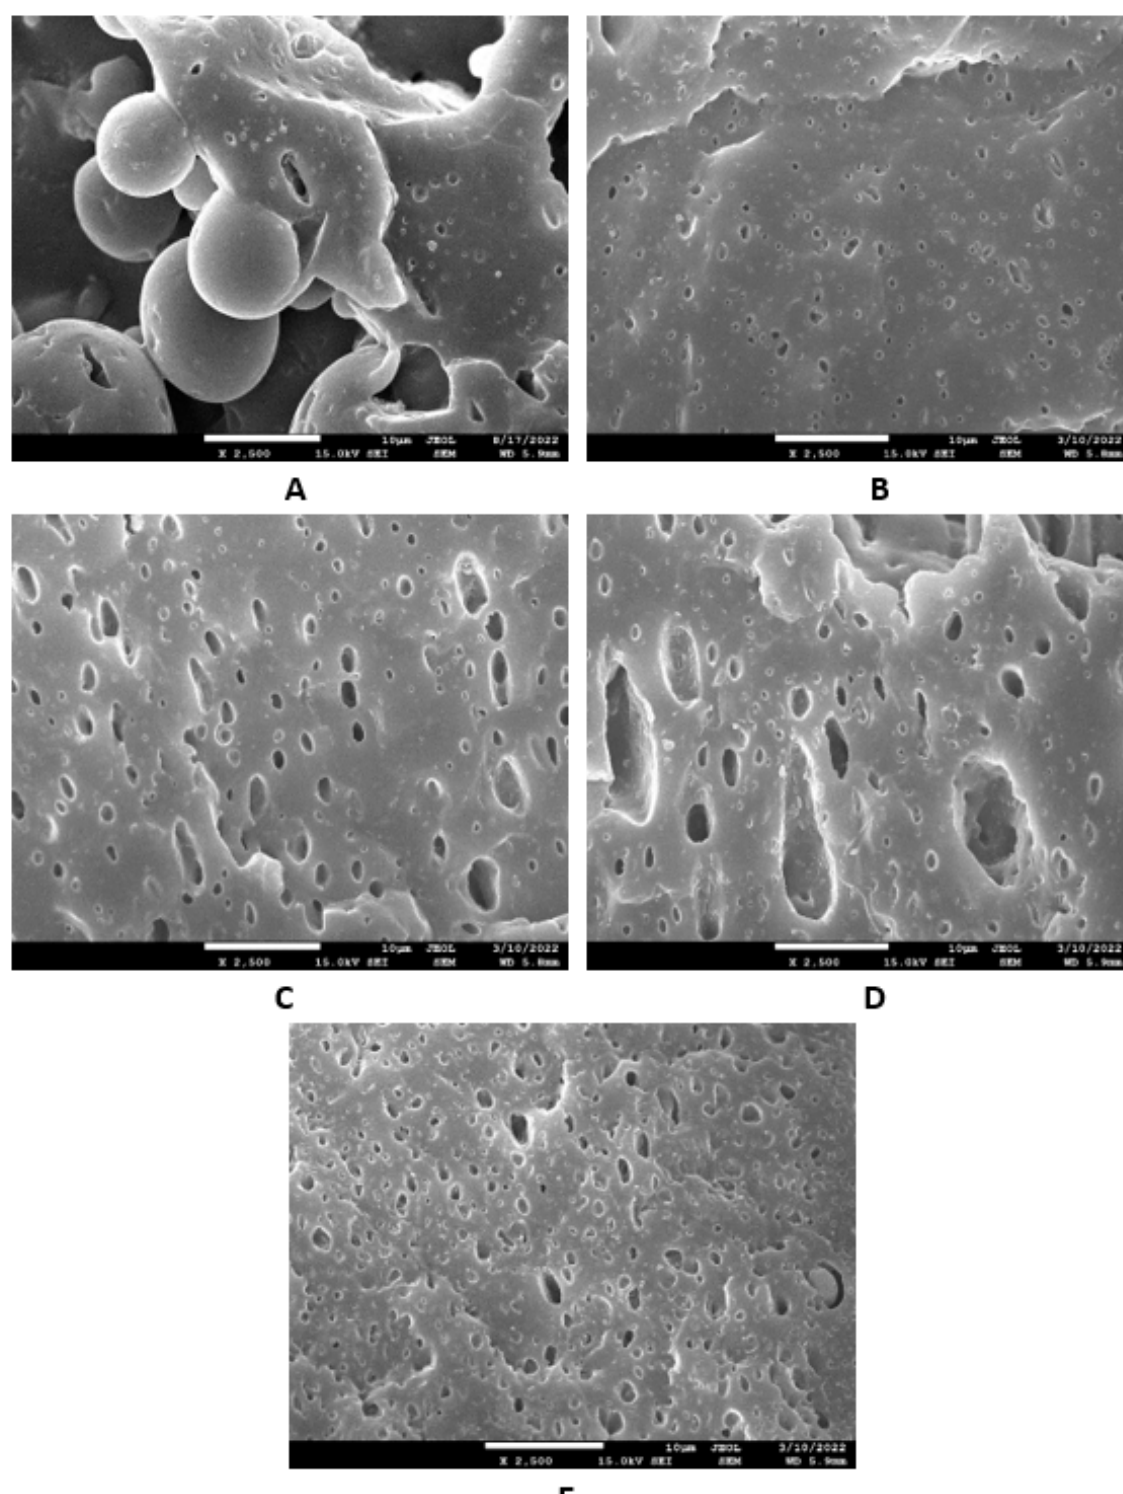
Figure 18. SEM images of vulcanizates based on NBR after washing in boiling water: ( A ) reference vulcanizate without glycerol, ( B ) vulcanizate with 5 phr of glycerol, ( C ) vulcanizate with 10 phr of glycerol, ( D ) vulcanizate with 15 phr of glycerol, and ( E ) vulcanizate with 20 phr of glycerol.